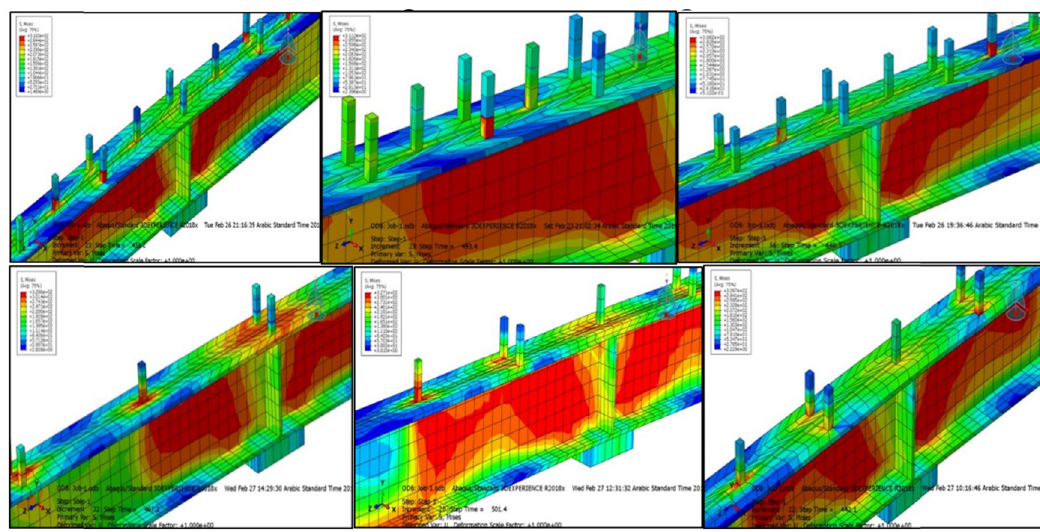
Figure 14: Stress distribution for specimens of Group C.